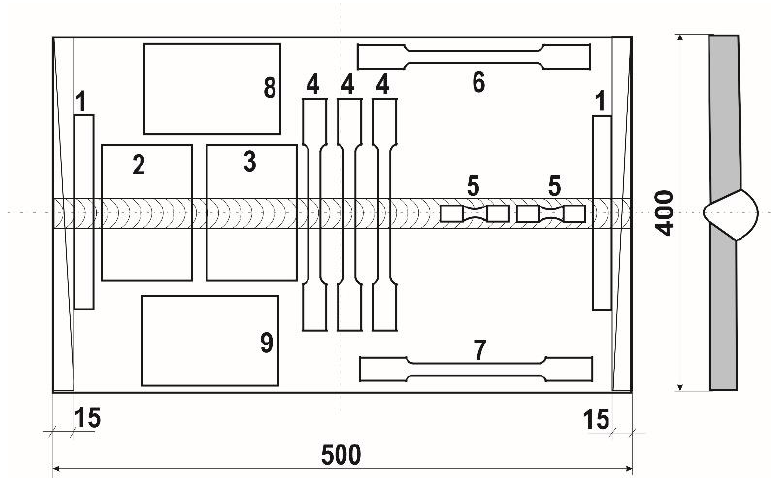
Figure 4 – Appearance of the welded plate scheme and the test tube cutting plan Рис. 4 – Вид схемы сварной пластины и план резки